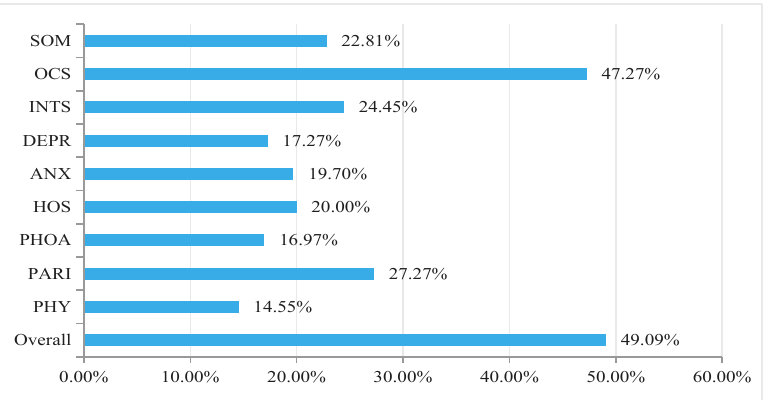
Figure 1. Detection rate in each dimensions of SCL-90-R among the PMWs.